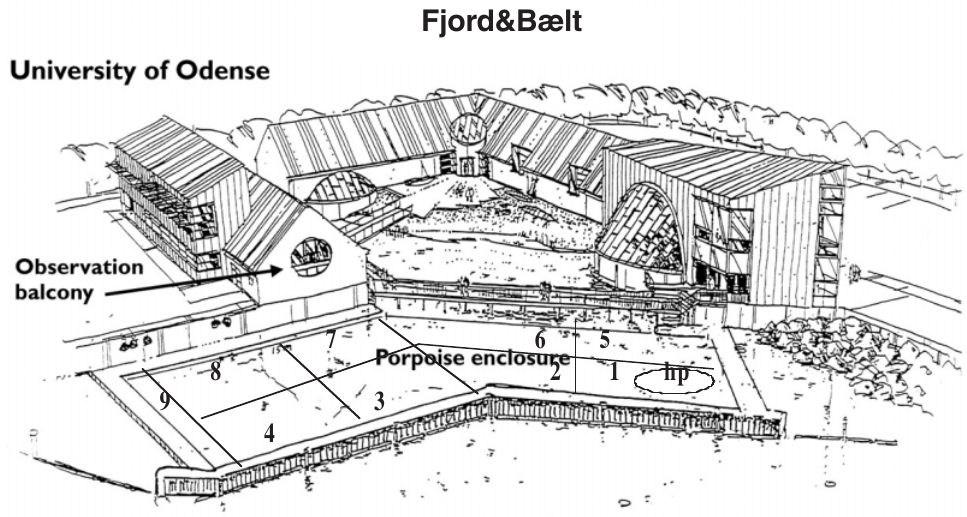
Fig. 1. Plan of the porpoise pool and general drawing of the Fjord&Bælt and the Research Centre for Aquatic Biology, Odense University. Numbered / coded sectors in the pool refer to the behavioural